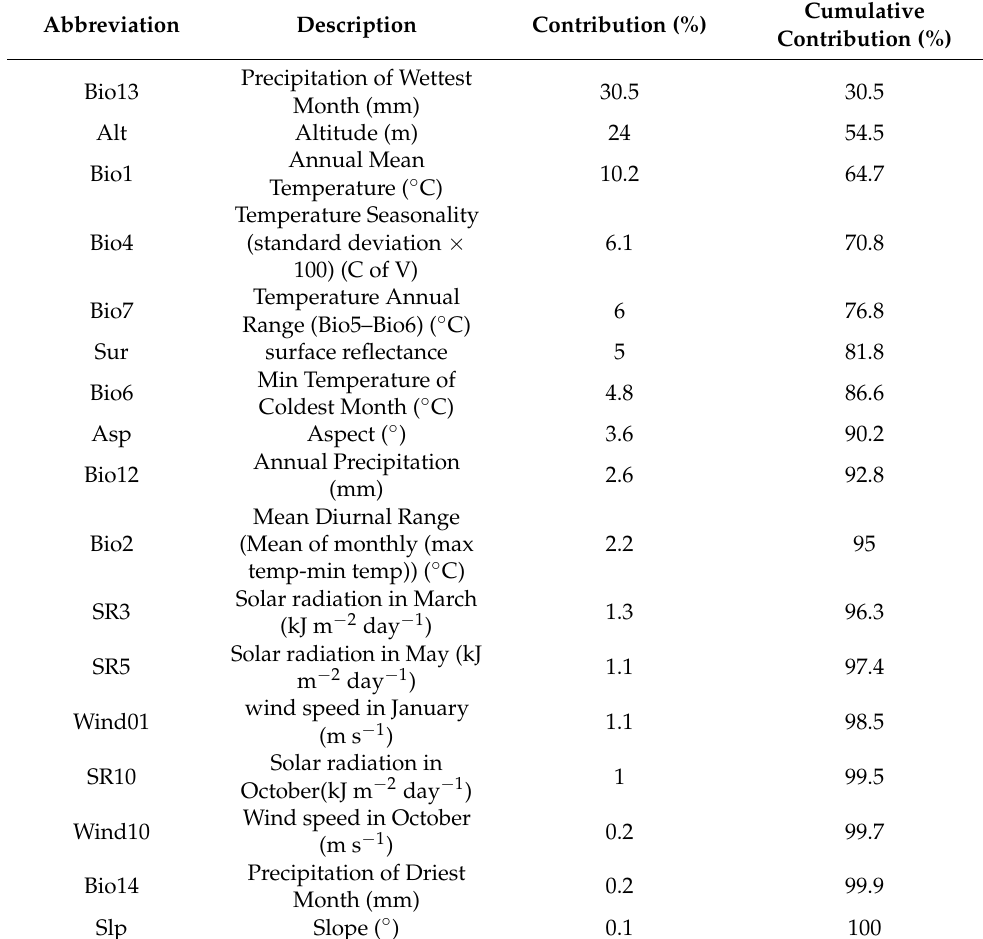
Table 2. Environmental variables used in the study and their contribution rate in simulating the potential distribution of